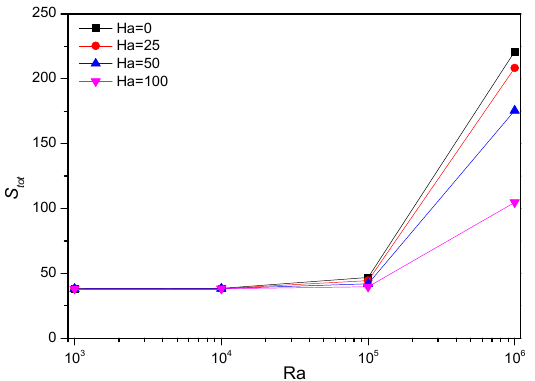
Figure 8. Average Nusselt number (Nu ave ) as a function of Rayleigh number (Ra) at various values of Darcy number (Da). φ = 0.02 and ε p = 0.4.